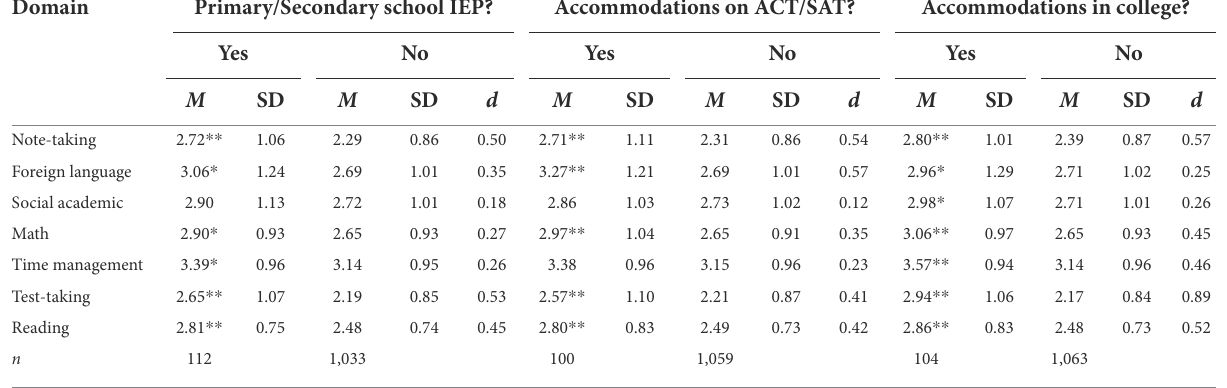
TABLE 6 Average AIM composite scores as a function of accommodation